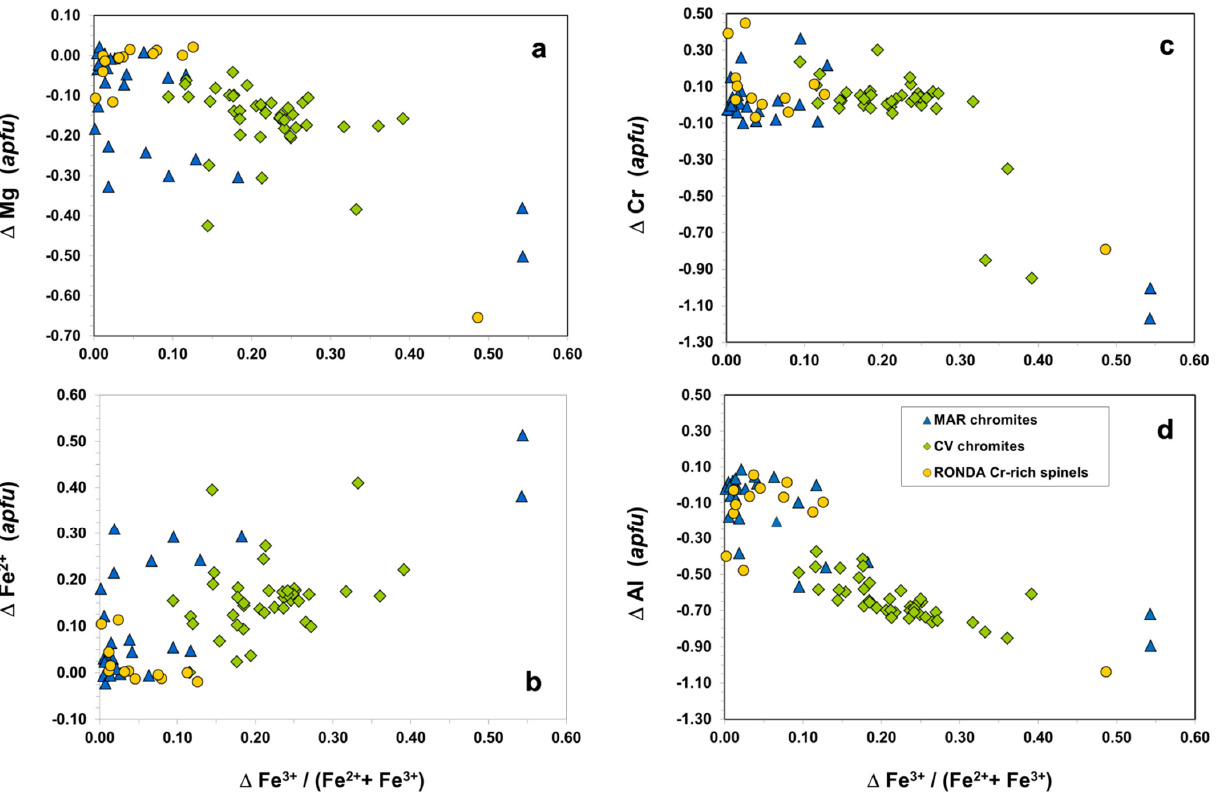
Figure 8. Variation of ( a ) Mg, ( b ) Fe 2+ , ( c ) Cr and ( d ) Al contents with increasing Fe oxidation rates in the MAR magnesiochromites, CV chromites, and Ronda chromian spinels. the MAR magnesiochromites, CV chromites, and Ronda chromian